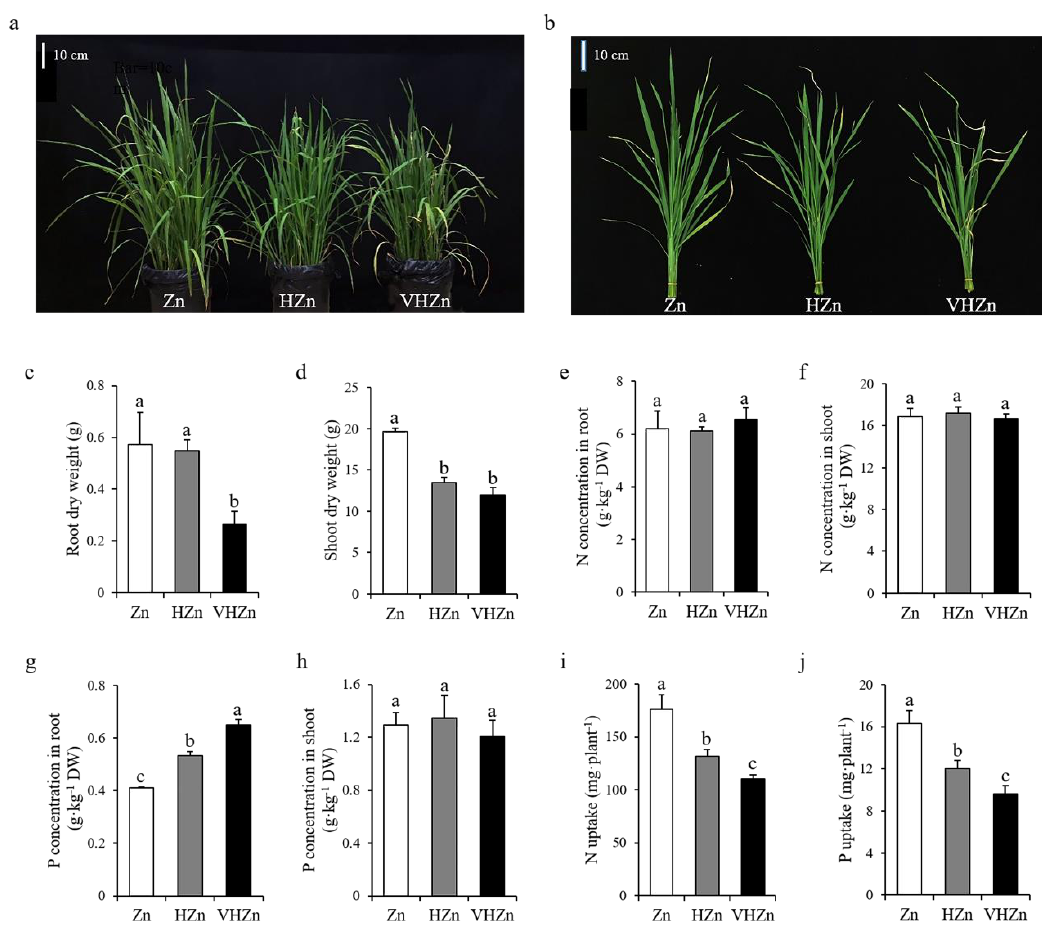
Figure 1. Growth phenotype ( a , b ), root and shoot dry weight ( c , d ), N concentrations in root and shoot ( e , f ), P concentrations in root and shoot ( g , h ), N and P uptake ( i , j ) of rice plant grown in soil with different levels of Zn (Zn: 10 mg . kg −1 soil; HZn: 200 mg . kg −1 soil; VHZn: 400 mg . kg −1 soil). Data are means ± SD of three biological replicates. Different letters indicate significant difference at p < 0.05 by Tukey’s test.